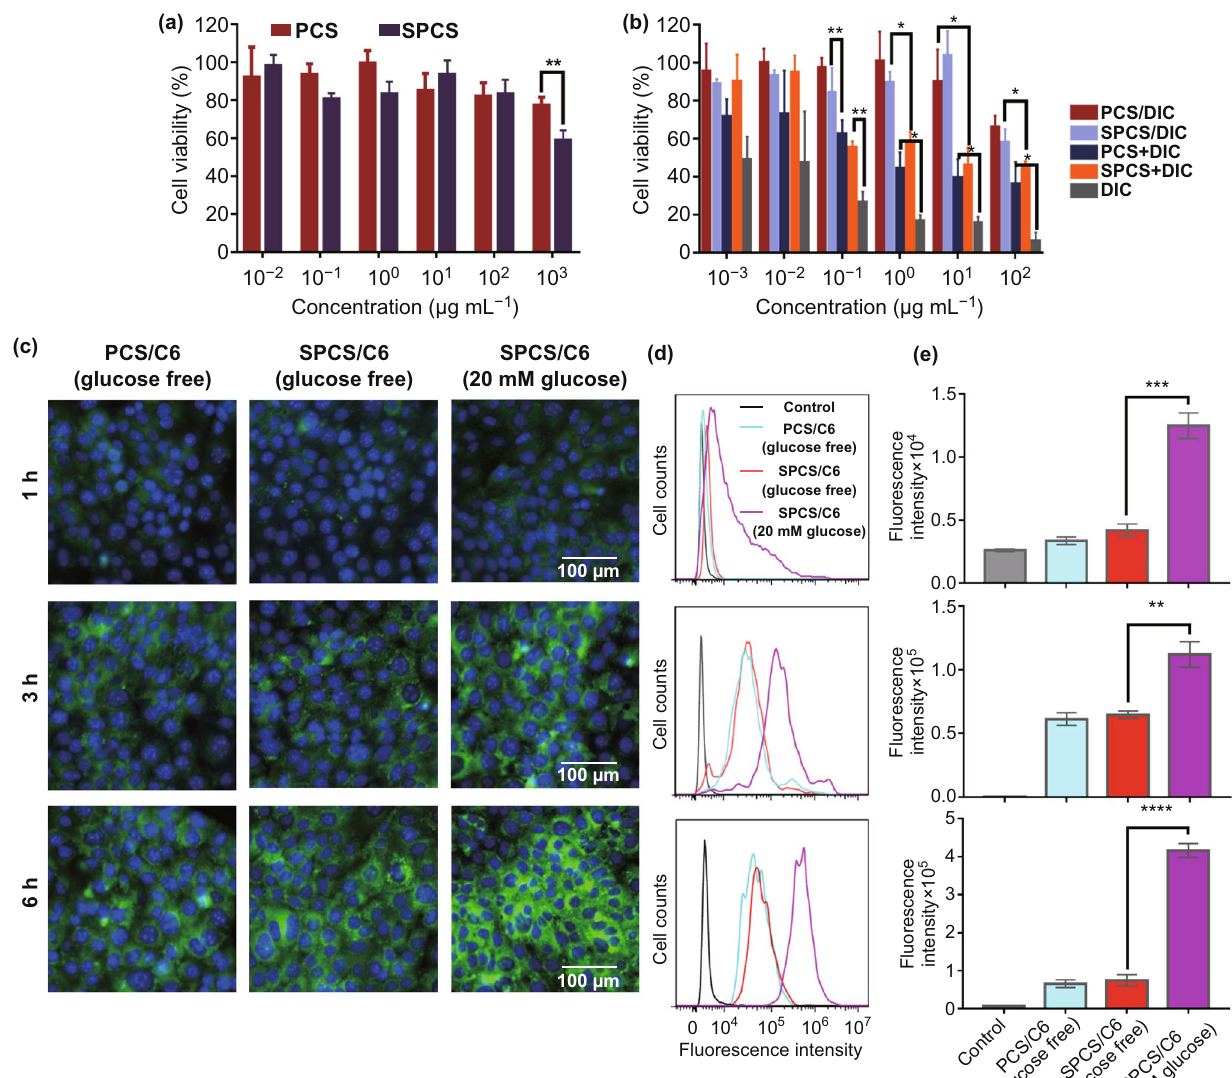
Figure 6 In vitro safety profile and cellular internalization. a Cytotoxicity of chitosan derivative and b DIC-encapsulated micelles against Caco 2 cells with different concentrations for 48 h. c Inverted fluorescence microscope images of PCS/C6 and SPCS/C6 micelles in Caco 2 cells under glucose free condition, and Caco 2 cells inculcated with SPCS/C6 at a glucose concentration of 20 mM. d Representative FACS images and e quantitative analysis of intracellular internalization of PCS/C6 and SPCS/C6 in Caco 2 cells at 1, 3 and 6 h. Data are expressed as mean ± SD, n = 3. * p < 0.05, ** p < 0.01, *** p < 0.001, **** p <